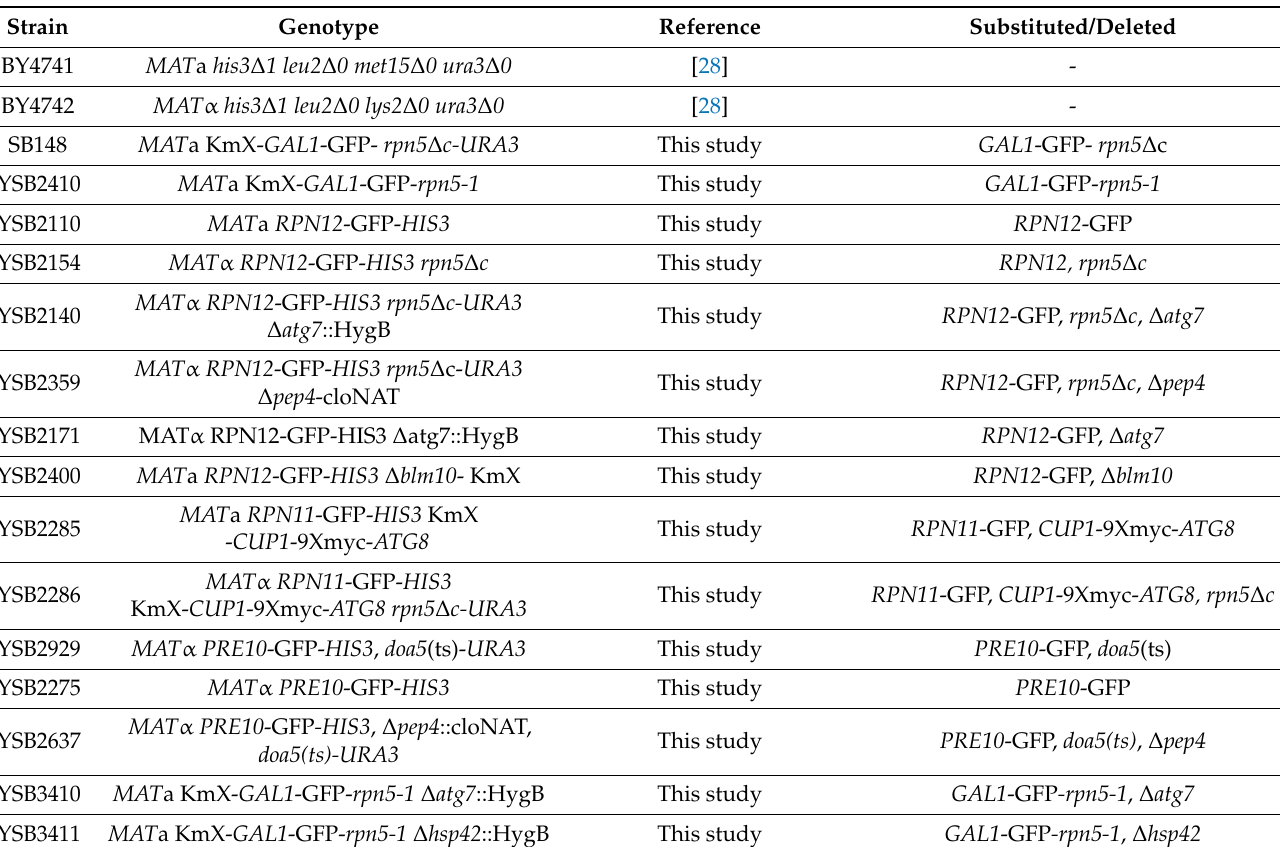
Table 1. Relevant genotype of strains used in this